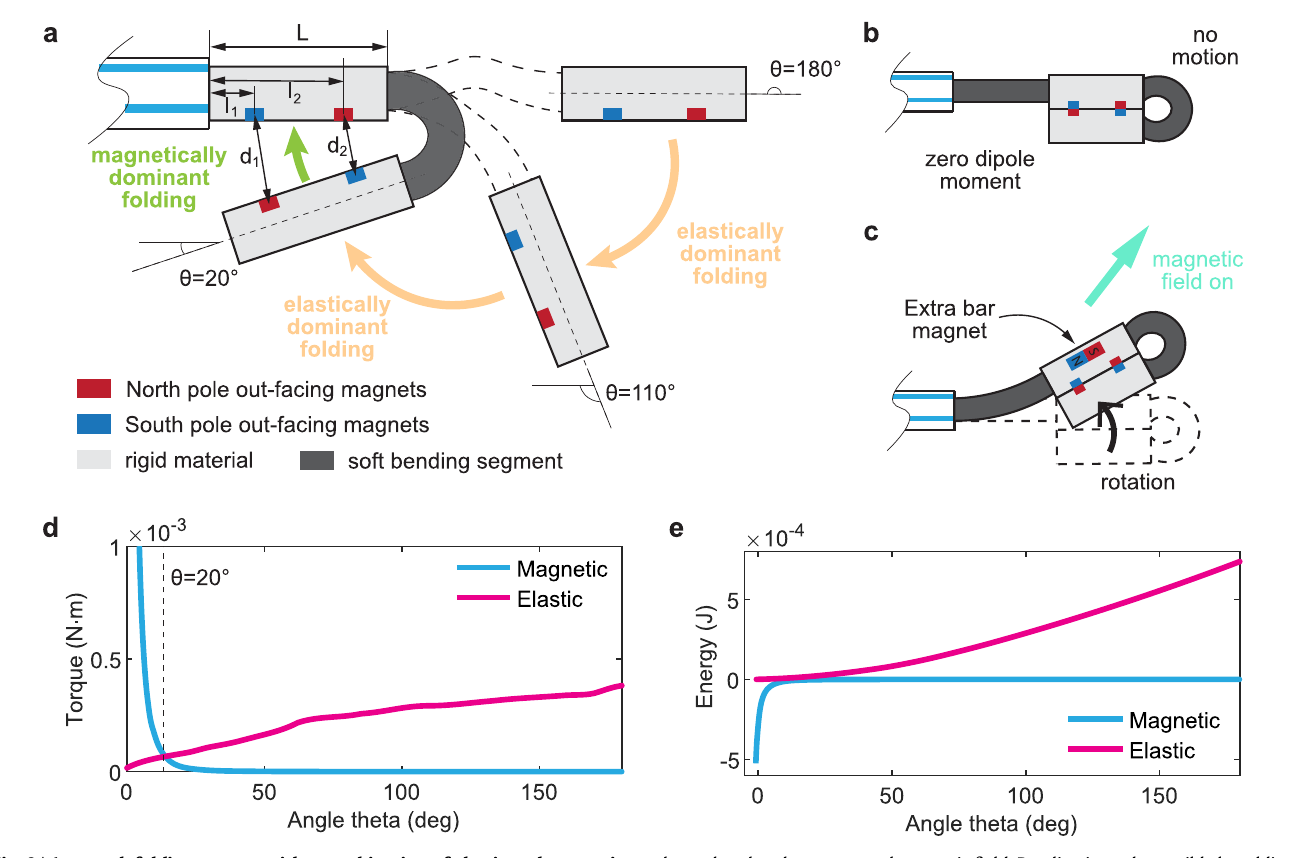
donot bend underanexternalmagnetic fi eld. Bending ismade possibleby adding anextrabarmagnet. d , e The overall torque and energy associatedwith the elastic and magnetic interactions at different folding angles θ . The elastic energy